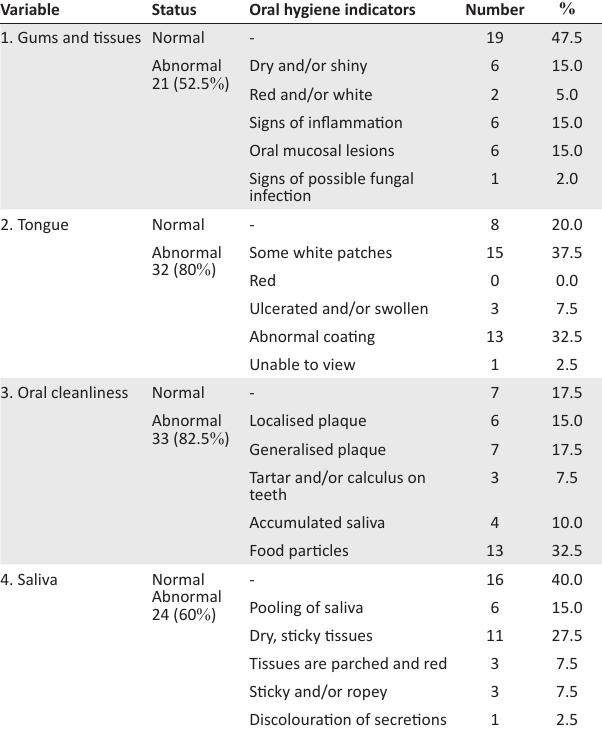
TABLE 4: Oral hygiene indicators relating to the most prevalent conditions of the oral cavity. Variable